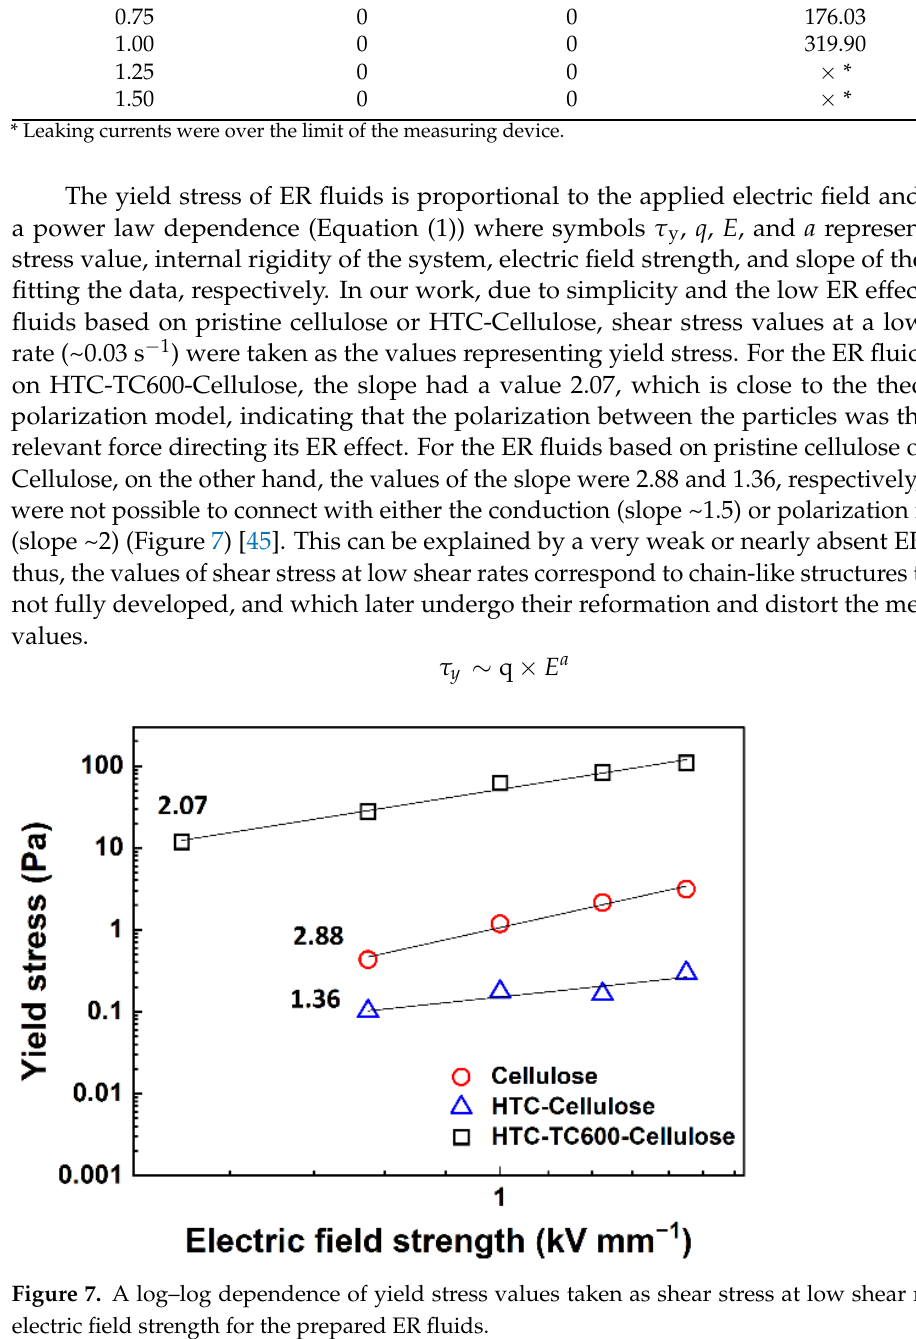
Table 1. Leaking current density of the prepared ER fluids.